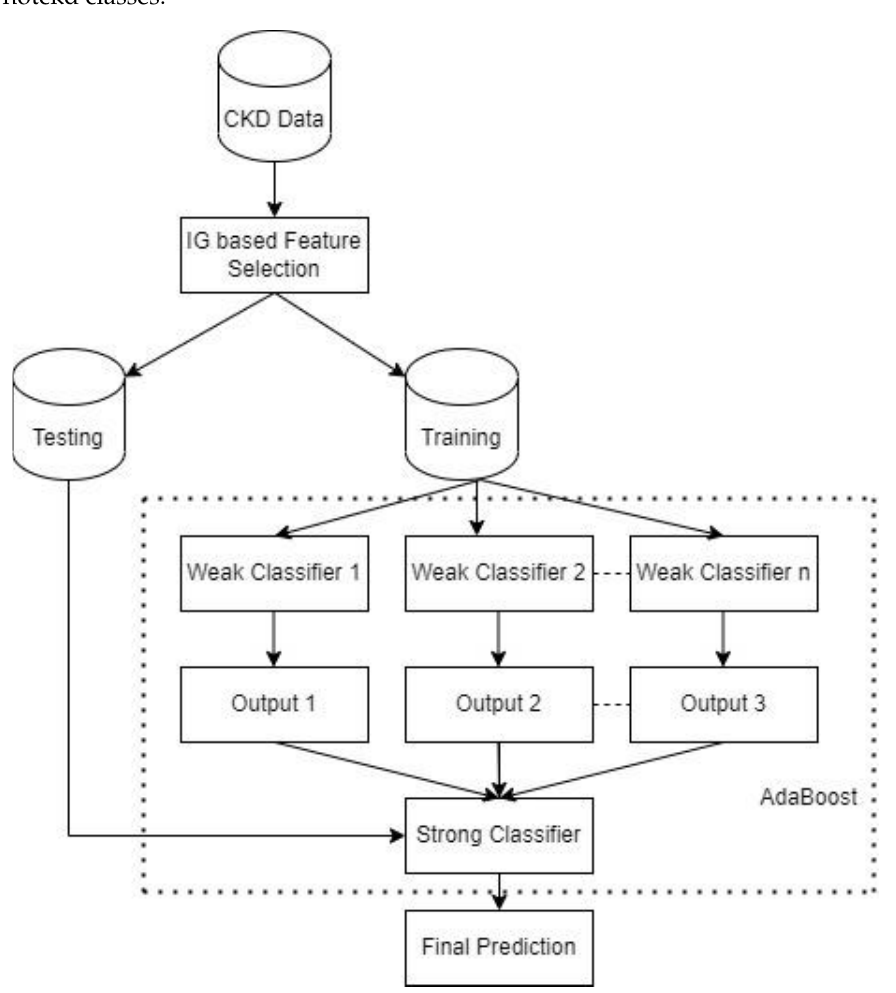
Figure 1. The architecture of the proposed approach.